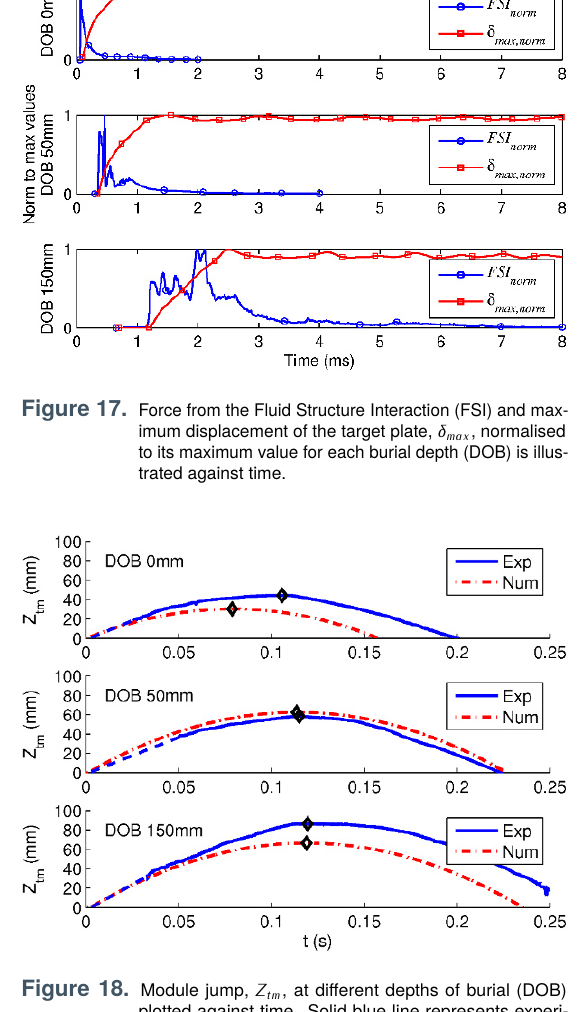
Figure 18. Module jump, Z tm , at different depths of burial (DOB) plotted against time. Solid blue line represents experi- ment, dashed red line represents numerical simulation. Diamonds indicate max Z tm .